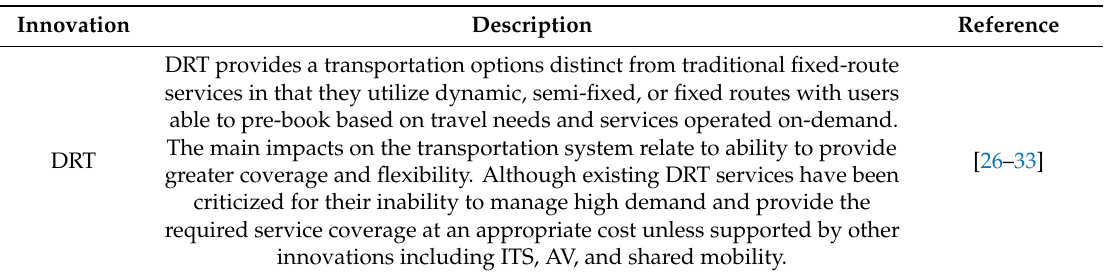
Table 2. Smart mobility innovations (source: